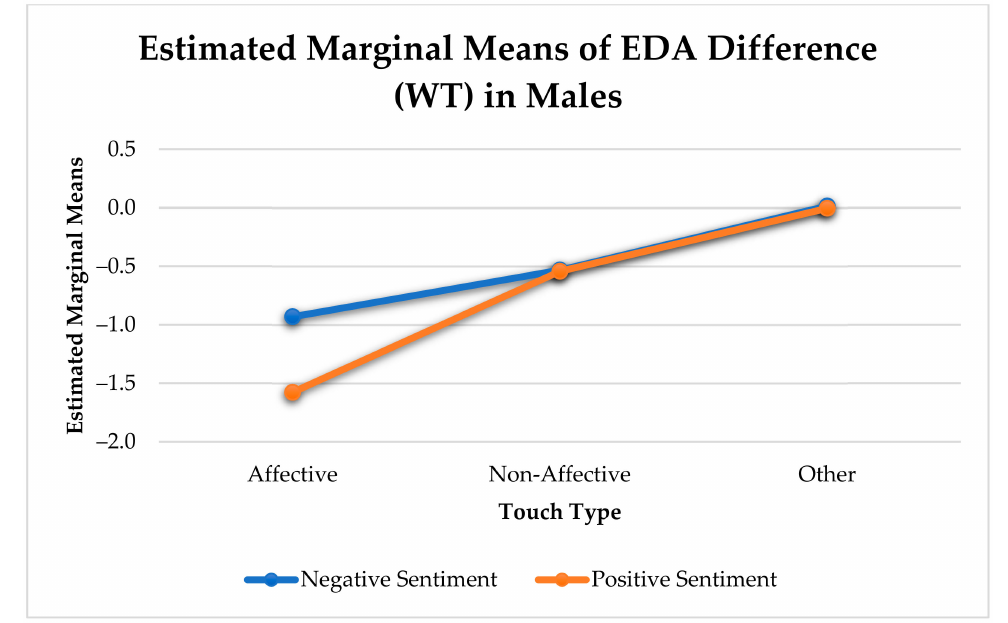
Figure 7. Physiological Arousal Change Elicited by Touch for Positive and Negative Sentiment in Males.